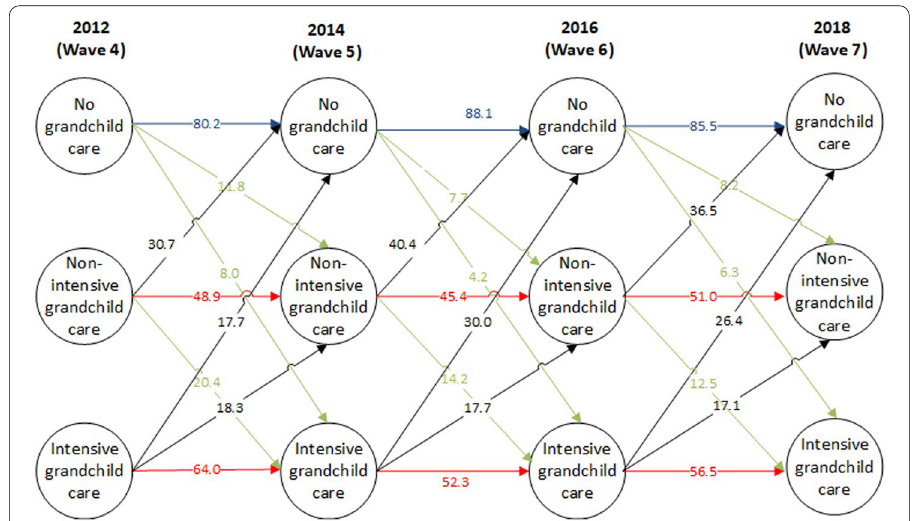
Fig. 1 Grandchild caring transitions in the 13 countries, 2012–2018 (Source: Authors’ analysis of the Harmonised SHARE Waves 4–7)